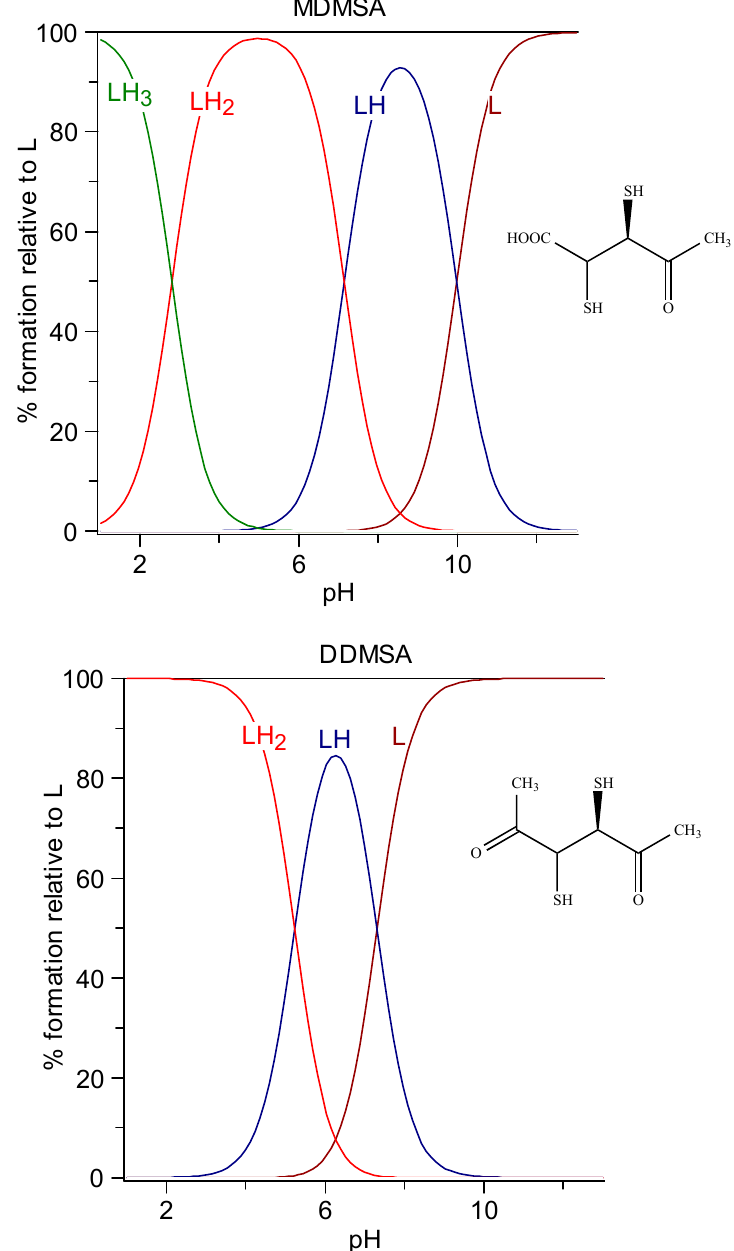
Figure 4. Speciation plots of methyl ‐ DMSA (top) and dimethyl ‐ DMSA (bottom).